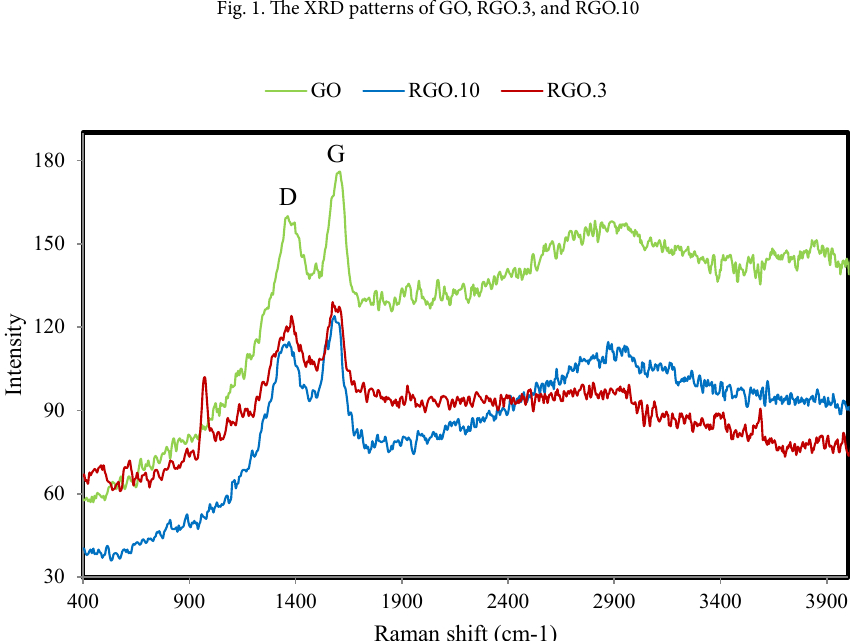
Fig. 2. Raman spectra of GO, RGO.3 and